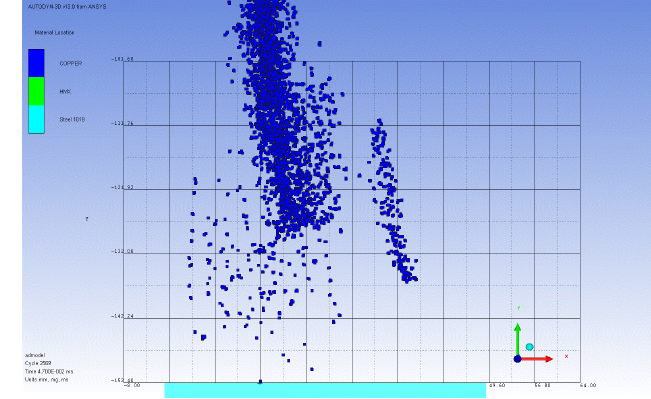
Figure 11. Cross sectional area of the jet split into 10 separate pieces for